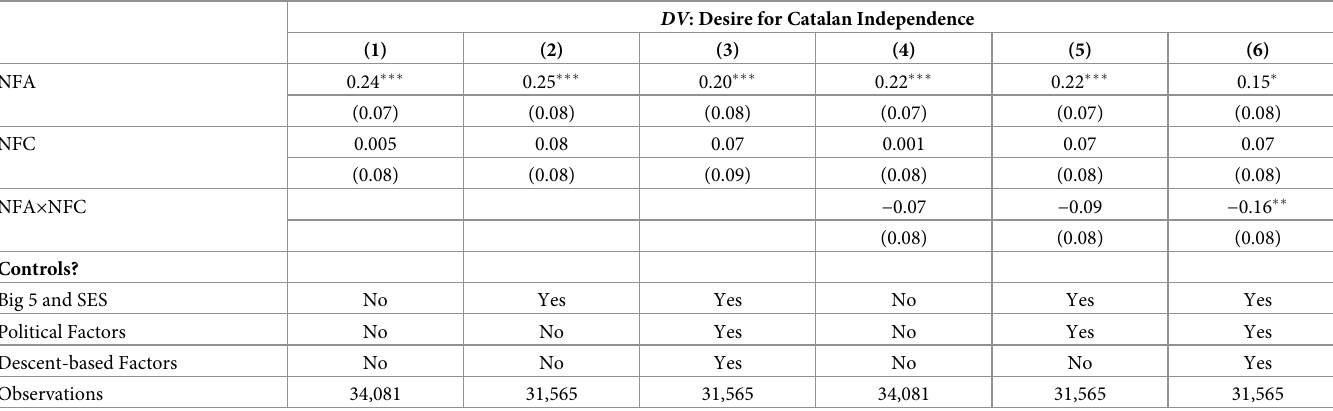
Table 1. The effect of Need for Affect, Need for Cognition on the desire for Catalan independence.